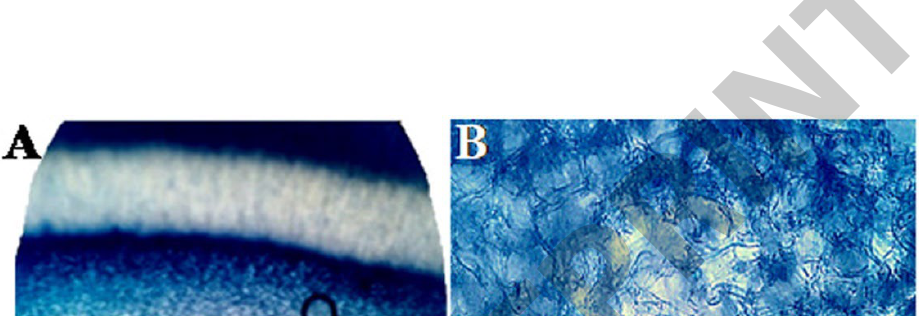
Figure 1 Images of Astraeus asiaticus . A. Young sporocarps collected from the field; B. Young sporocarp; C. Mature sporocarp.